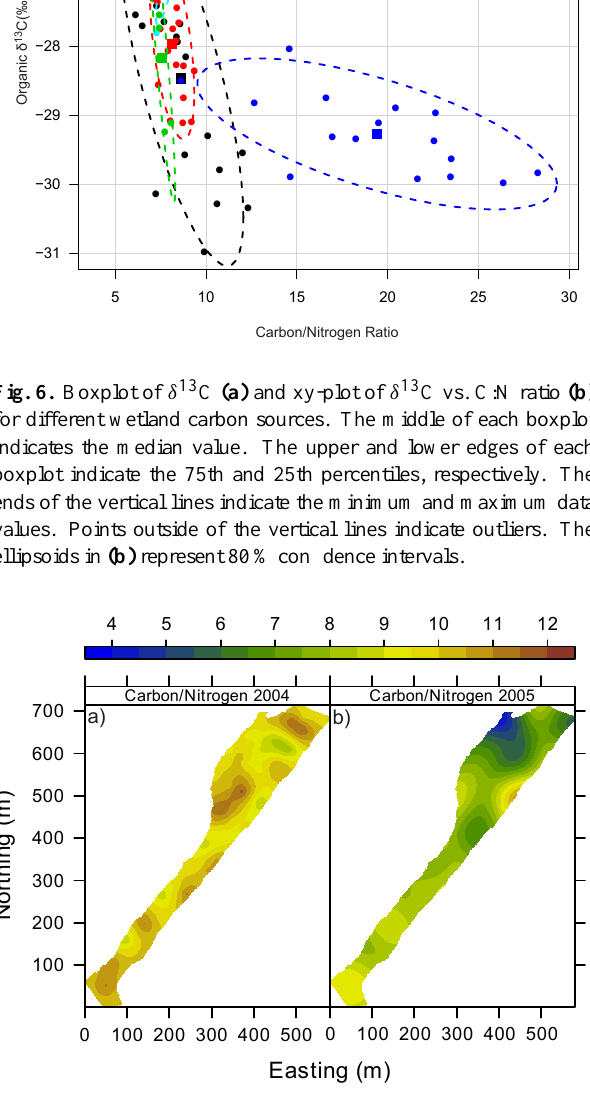
Fig. 7. Interpolation map showing the C:N ratios in (a) 2004 and (b)